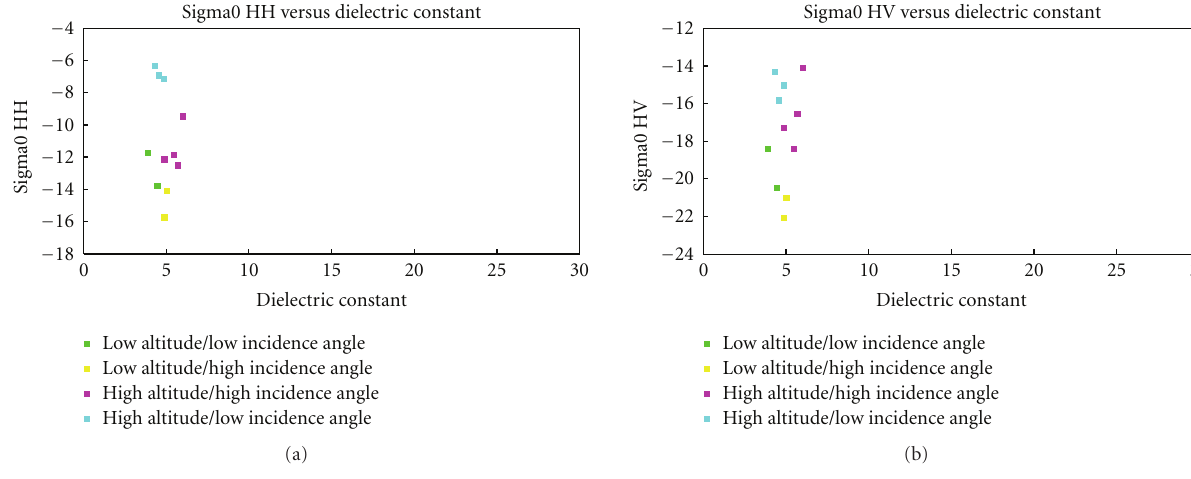
Figure 4: Scatter plots of backscattering coe ffi cients extracted from the RADARSAT2 images versus dielectric constant measurements over pasture areas and with dielectric constantvalues between 4.5and 5.5 in the case of (a)HH polarizationconfigurationand (b) HV polarization configuration. The samples are grouped into 4 clusters according to the topographic features extracted from the